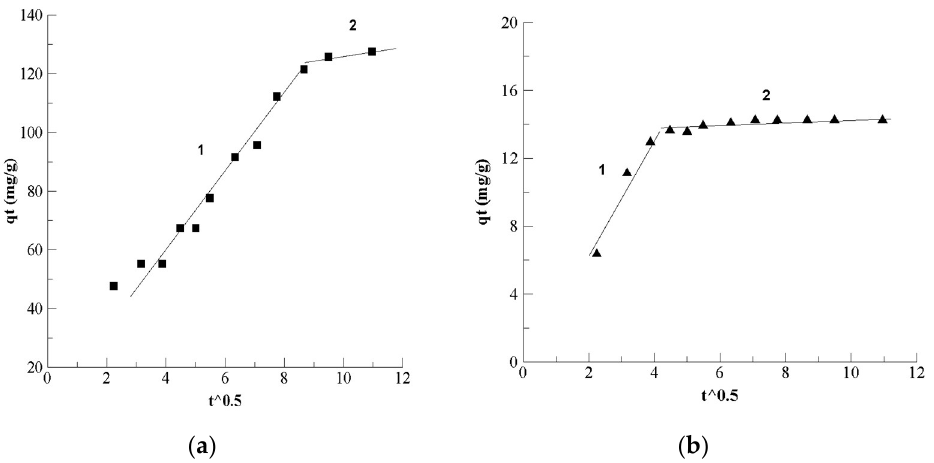
Figure 10. Application of Webber and Morris equation to the adsorption data of ( a ) sinigrin and ( b ) gluconapin using PA312LOH resin (resin concentration 20 g/L, 30 °C). The experimental points are represented by the symbols “ ■ ” and “ ▲ ”